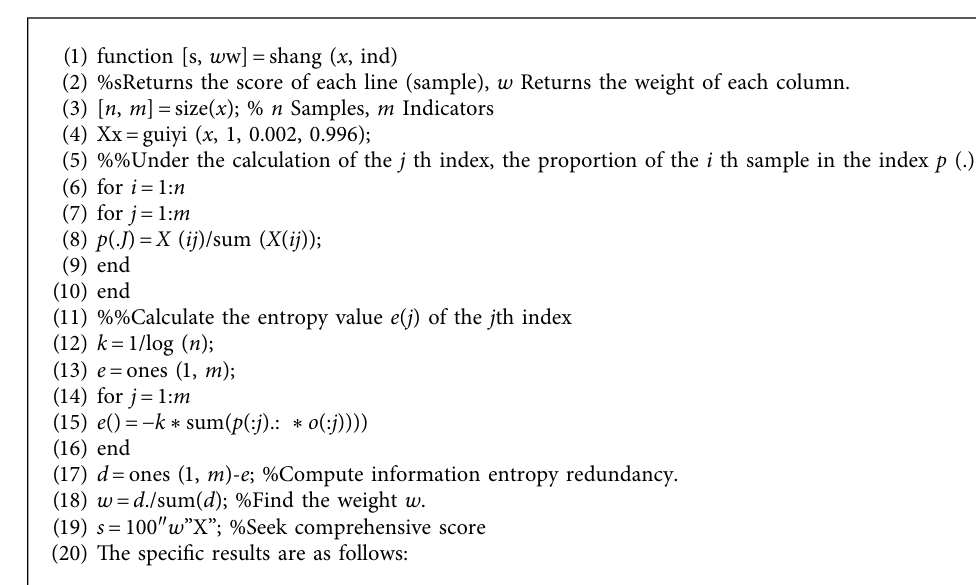
U21 channel water depth: quantitative indicators, usually expressed as “meters.” Number of U22 berths: quantitative indicators. U23 port and wharf length: quantitative indicators, usually expressed as “meters.”